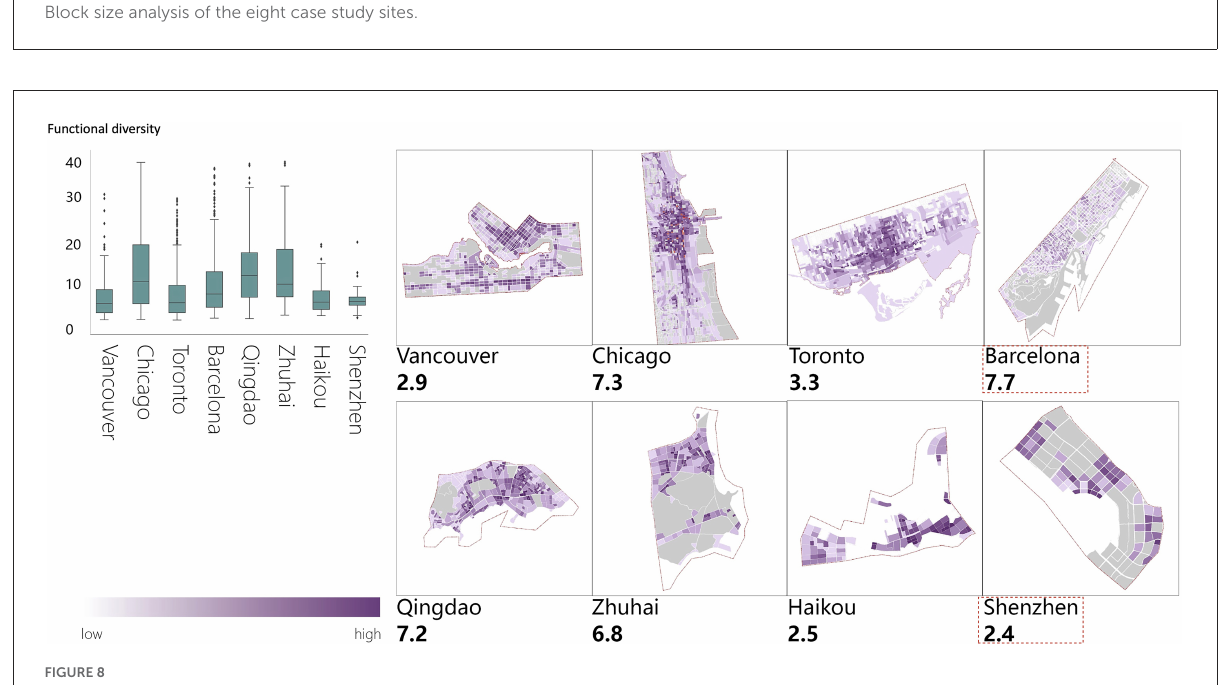
FIGURE8 Functional diversities in the eight case study